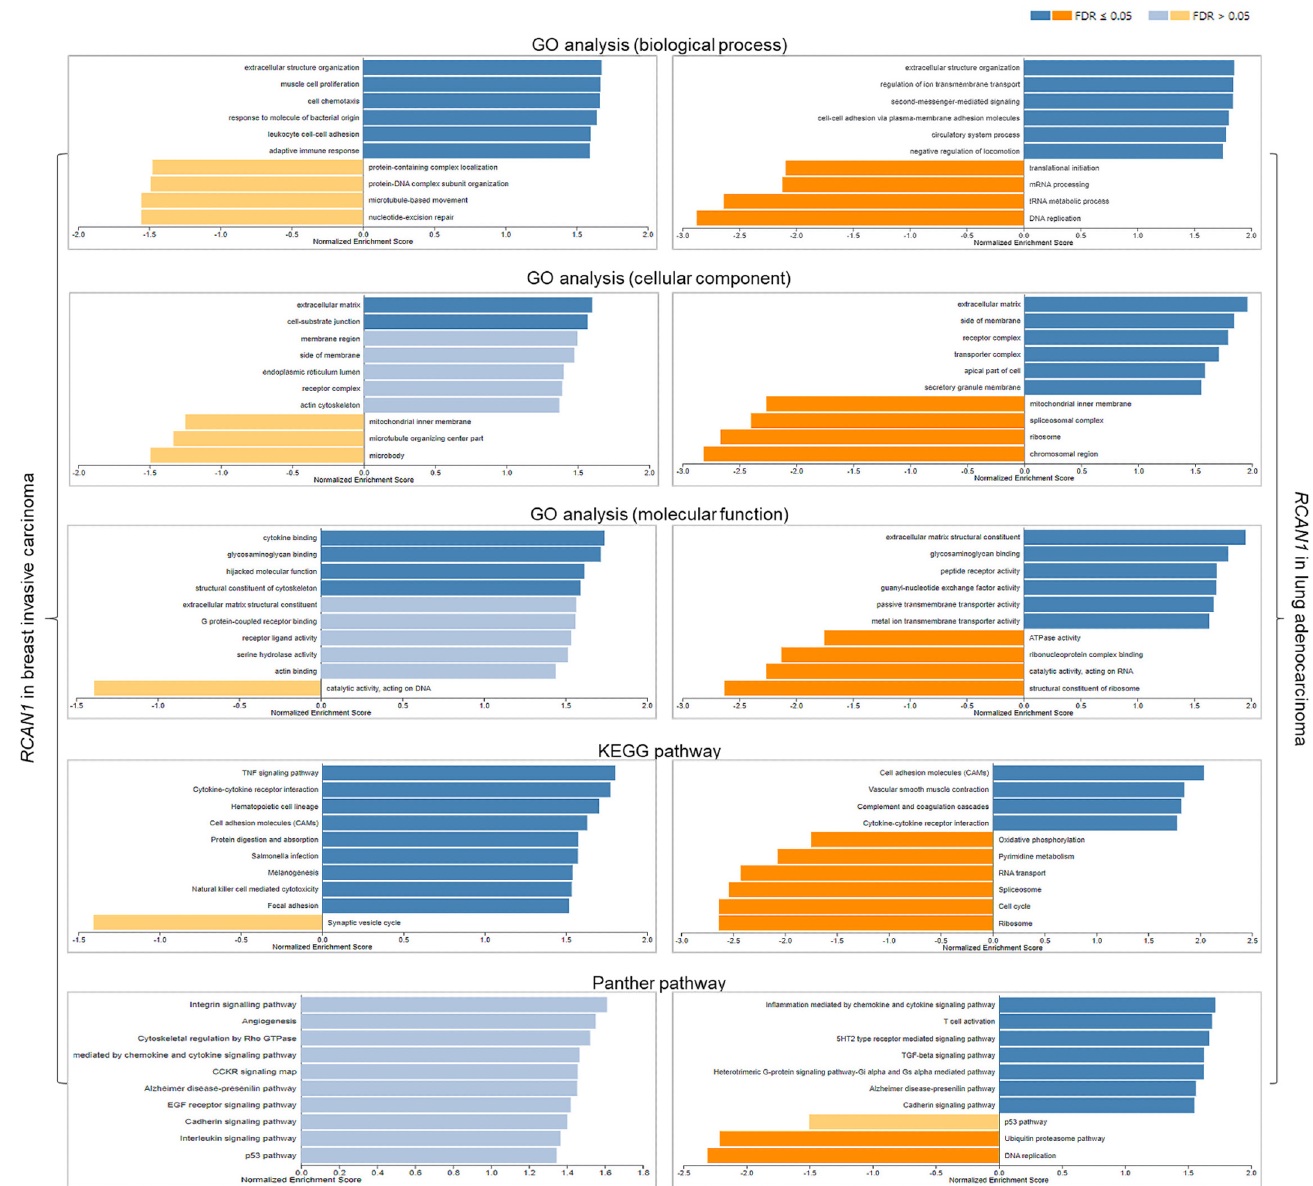
Figure 8. Functional analyses of RCAN1 in breast and lung cancers. Blue bars: gene clusters positively correlated with RCAN1 , orange bars: gene clusters negatively correlated with RCAN1 . FDR: false discovery rate.